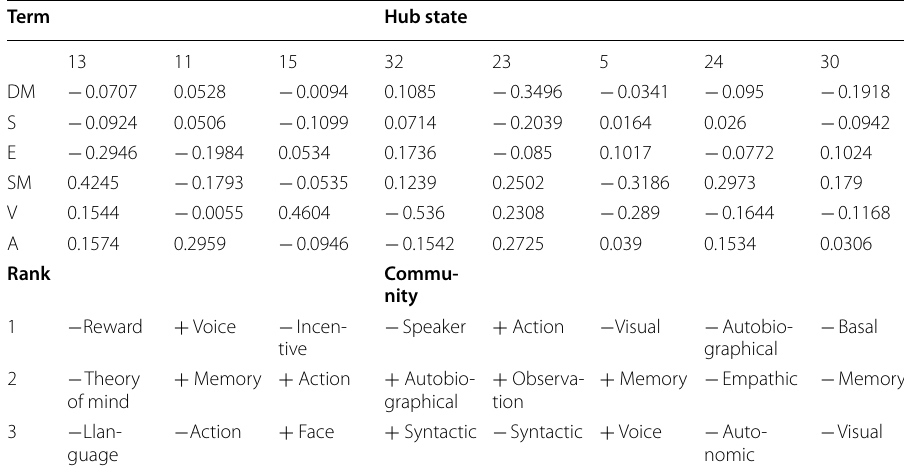
The terms scored by NeuroSynth are the resting state terms default mode (DM), salience (S), executive (E) and sensory terms sensorimotor (SM), visual (V) and auditory (A). The first rows of the table under hub states show the NeuroSynth correlation score between each of the hub states’ brain maps and the terms on the left (see Additional file 1: Figure S-2). The second section under terms shows the most probable terms associated with each of the top three communities identified by our ranking method, providing further information on the component functional communities of these states. The sign next to each term indicates whether the association is positive or negative (depending on the sign of the brain regions